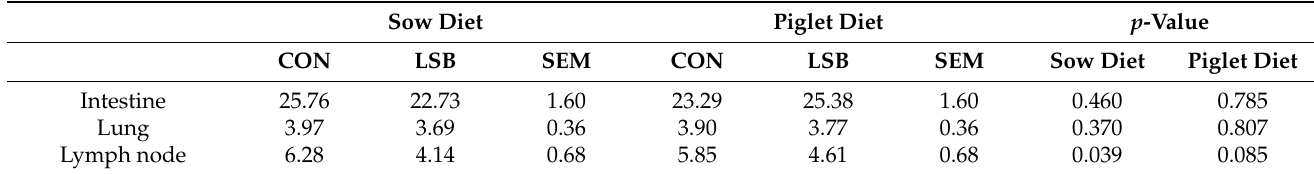
Table 6. IgA producing cells per sow treatment and tissue by sow diet and piglet diet (n/10,000 µ m 2 ).